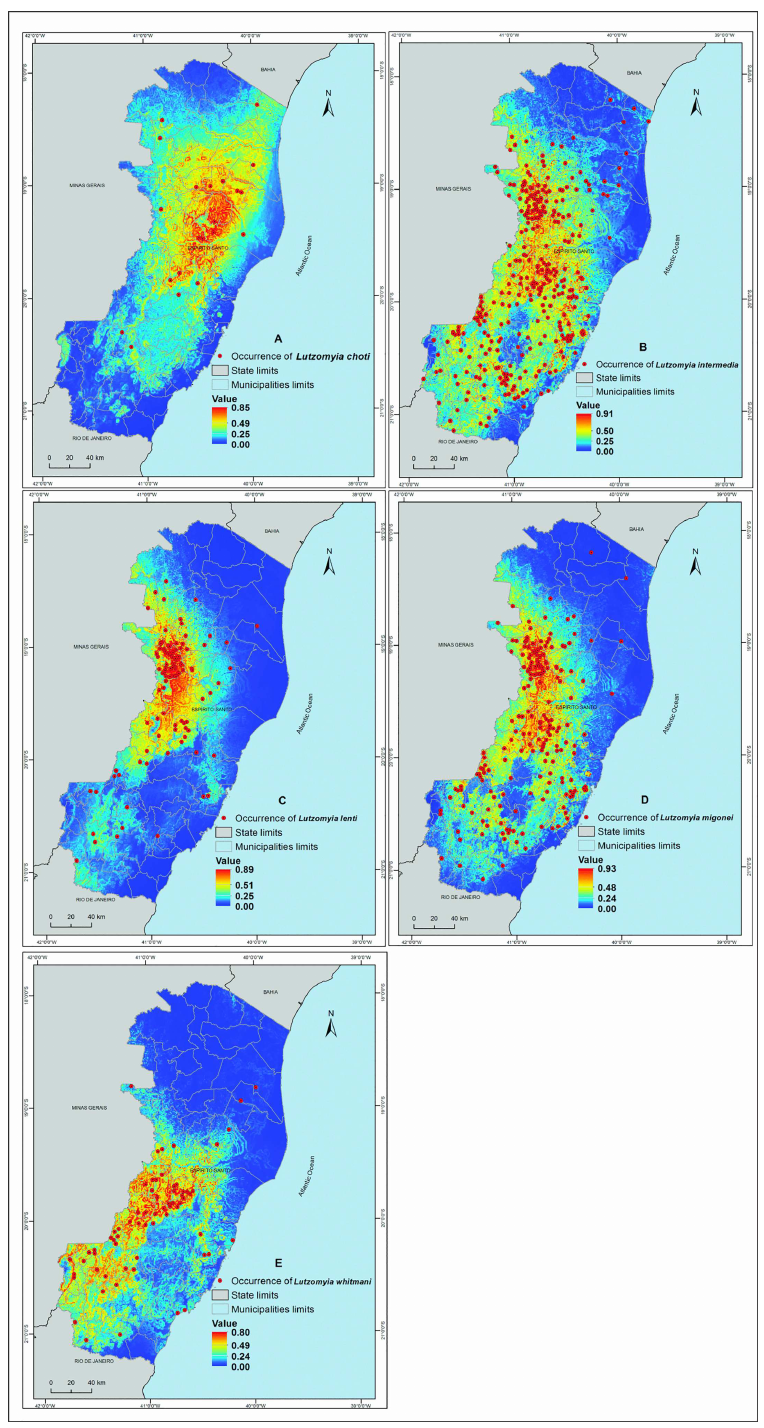
Fig 3. Predicted ecological niche distribution of five most frequent Phlebotominae species in the state of Espı ´ rito Santo, southeastern Brazil, during the period between 1997 and 2013. (A) Lutzomyia choti , (B) Lutzomyia intermedia , (C) Lutzomyia lenti , (D) Lutzomyia migonei and (E) Lutzomyia whitmani . The species occurrence probability is expressedwith values rangingfrom 0 to 1. Datum: SIRGAS 2000.